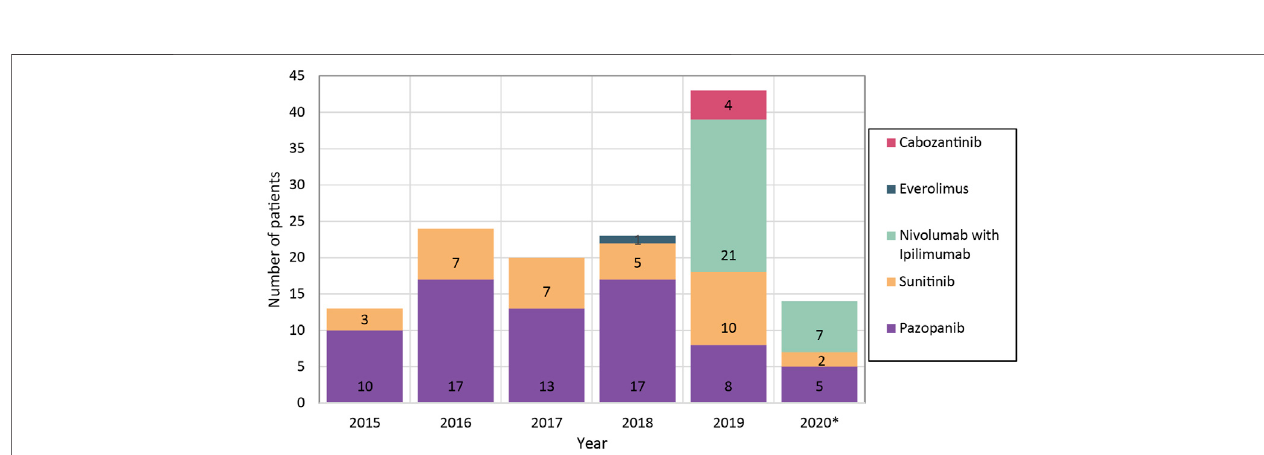
FIGURE 2 | Number of fi rst-line treatments started per year. *Patients included until May 2020.